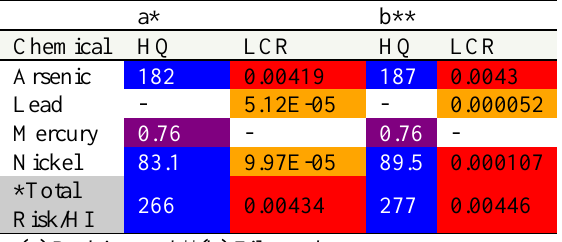
Table 12. LCR and HQ of heavy metals based on